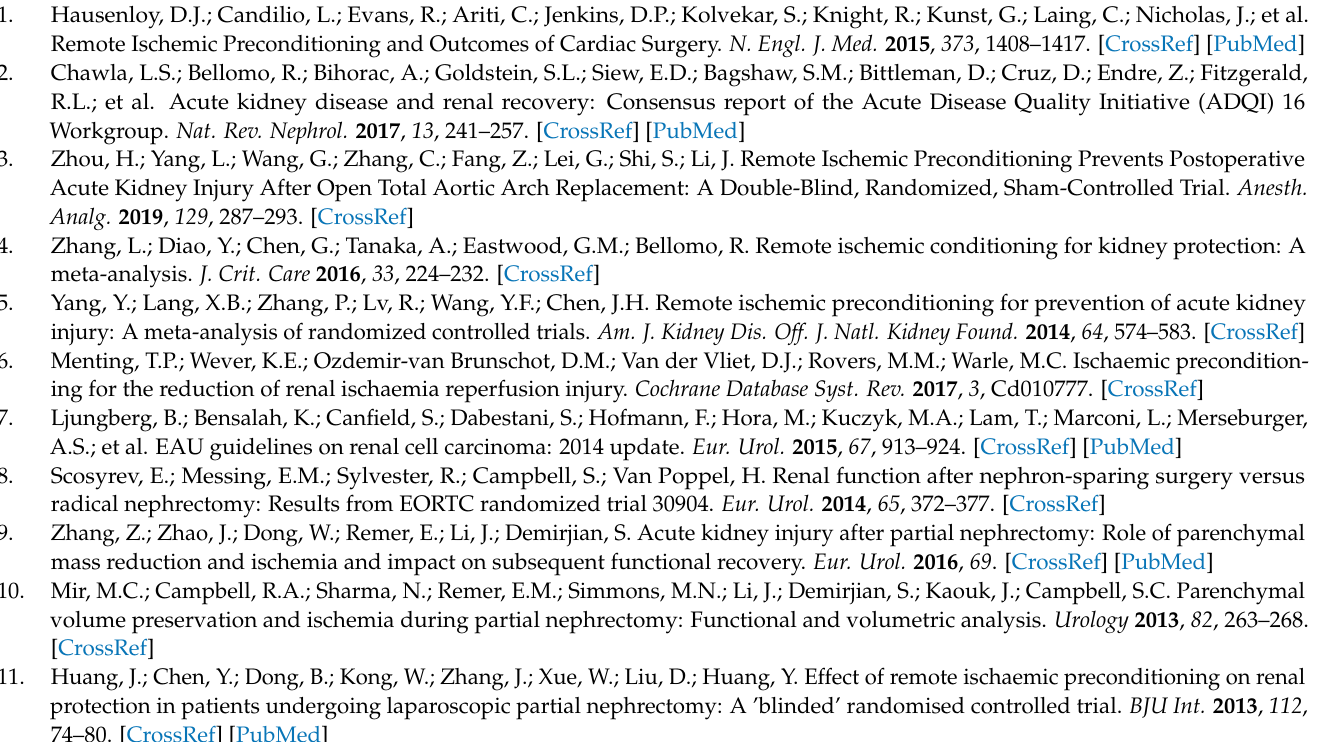
Comparison of time-dependent changes of the total glomerular filtration rate measured by 99mTc- DTPA renal scintigraphy between the RIPC and control groups. Supplementary Figure S6. Compari- son of time-dependent changes of the normalized glomerular filtration rate measured by 99mTc-DTPA renal scintigraphy between the RIPC and control groups. Supplementary Figure S7. Comparison of time-dependent changes of the regional O 2 saturation (rSO 2 ) during partial nephrectomy between the RIPC and control groups. Supplementary Figure S8. Comparison of time-dependent changes of high-sensitive C-reactive protein between the RIPC and control groups. Supplementary Figure S9. Comparison of time-dependent changes of urine creatinine between the RIPC and control groups. Supplementary Figure S10. Comparison of time-dependent changes of urine microalbumin between the RIPC and control groups. Supplementary Figure S11. Comparison of time-dependent changes of urine β -2 microglobulin between the RIPC and control groups. Supplementary Figure S12. Compari- son of time-dependent changes of urine N-acetyl-beta-D-glucosaminidase (NAG) between the RIPC and control